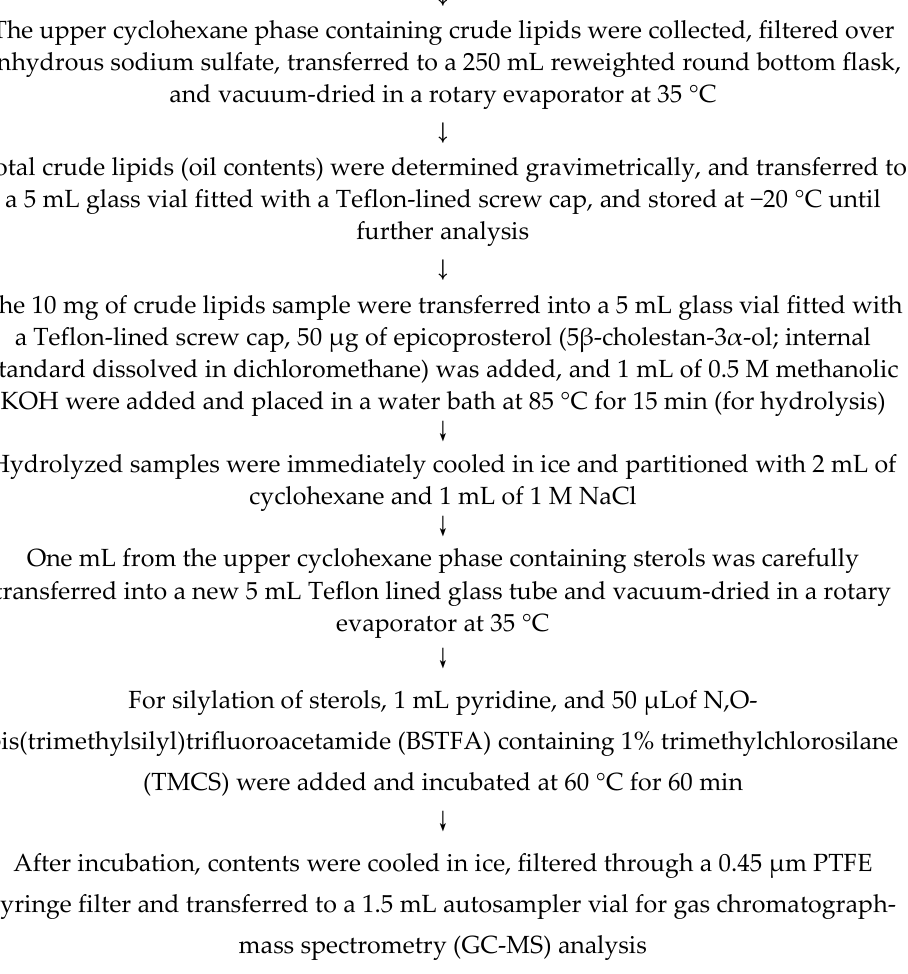
Figure A2. Outline of the method used for the extraction of crude lipids, hydrolysis, and silylation of sterols.